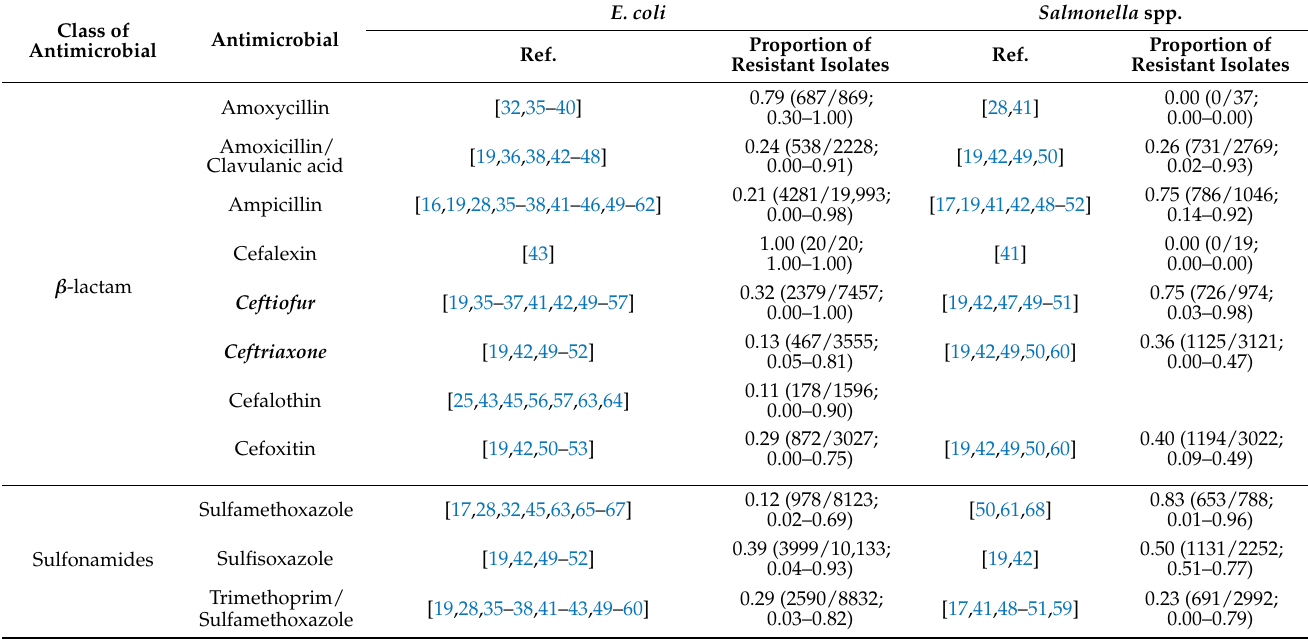
Table 4. Antimicrobial resistance patterns for E. coli and Salmonella spp. isolated from dairy calves with diarrhea. The total number of studies and the corresponding references were listed for each pathogen. Number of resistant isolates divided by the total number of isolates for each antimicrobial are displayed. Critically important antimicrobials (according to WHO) with the highest priority are marked in bold and italic. Salmonella